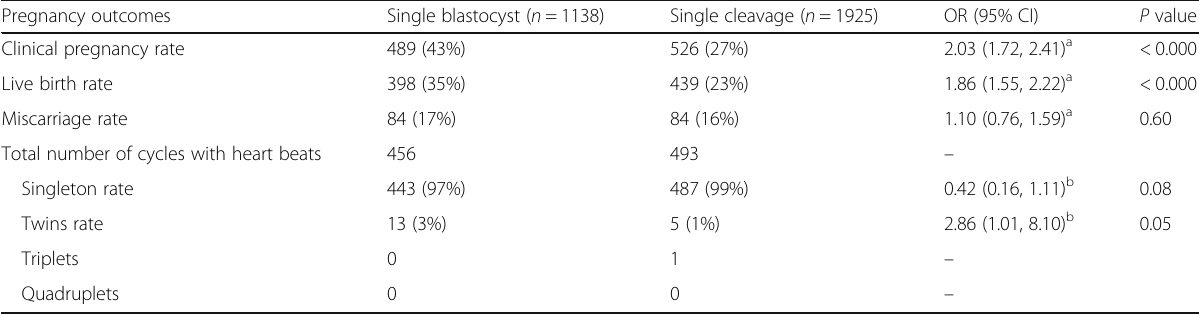
Table 2 Pregnancy outcomes by single blastocyst and single cleavage Pregnancy outcomes